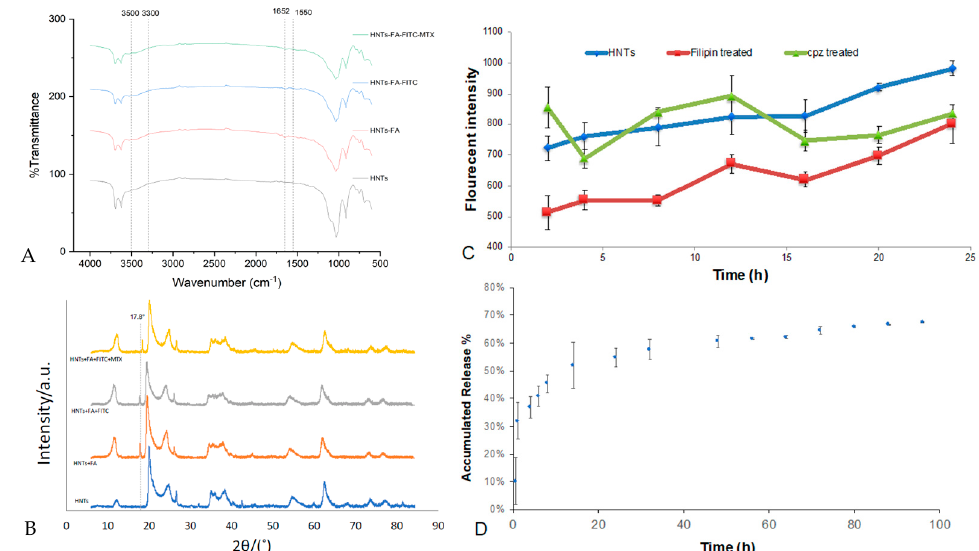
Figure 7. ( A ) FTIR detection of pure HNTs, HNTs-FA, FA/FITC-HNTs and FA/FTIC/MTX-HNTs. ( B ) XRD patterns of pure HNTs, HNTs-FA, FA/FITC-HNTs and FA/FTIC/MTX-HNTs. ( C ) Fluorescent intensity of FITC included in cells that pretreated by chlorpromazine (CPZ) or filipin and co-cultured with bi-HNTs for different time periods. (error bar with standard deviation, n = 6) ( D ) Accumulated drug release profile of methotrexate in 96 hours. (Error bar with standard deviation, n = 3).